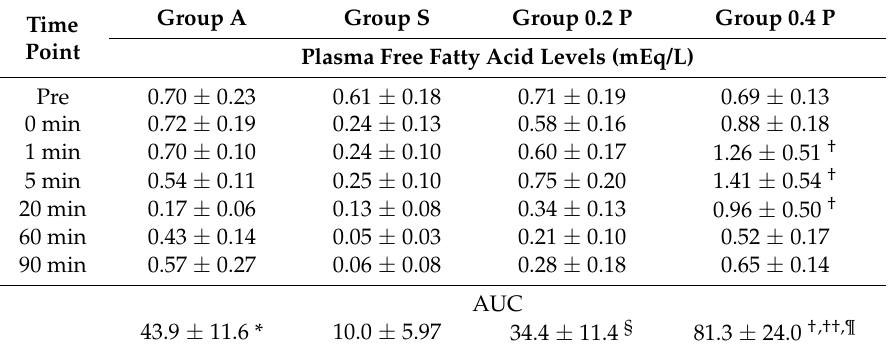
Table 5. Changes in free fatty acid concentrations after the glucose challenge and the area under the curve (AUC). Pre (before anesthesia induction): each time point indicates the elapsed time after the glucose challenge; 0 min means just before the glucose injection. Data are expressed as mean ±